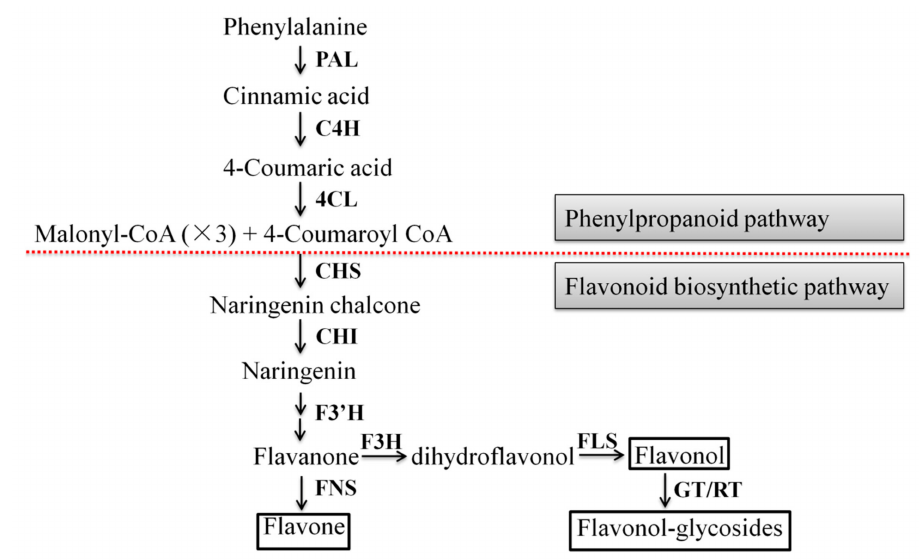
Figure 8. The flavonoid biosynthetic pathway in A. roxburghii . Bold words indicate the key enzymes in flavonoid biosynthesis. Compounds in the box show flavones, flavonols and flavonol-glycosides studied in this study.